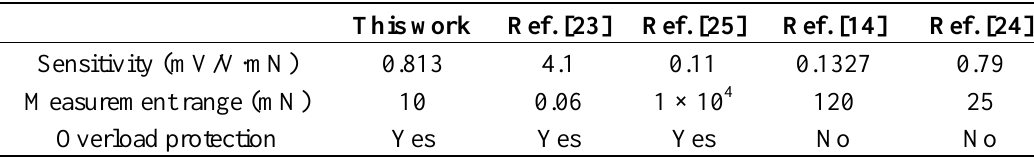
Table 1. Comparison with the existing